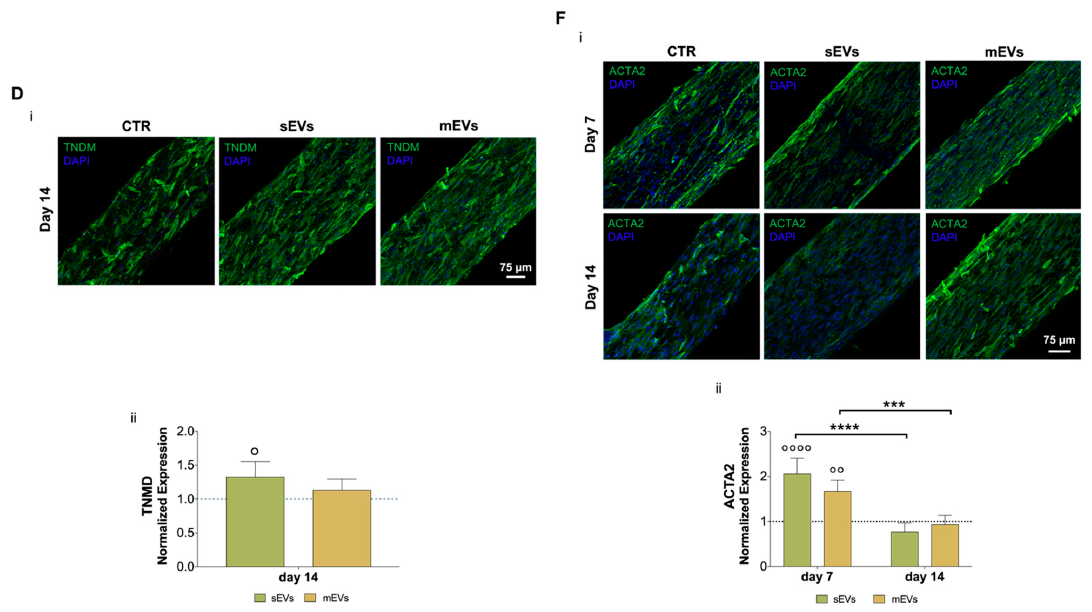
Figure 2. ( A ) Schematic representation of human tendon-derived stem cells (hTDCs) in culture over time. hTDCs were maintained in culture for 14 days to acquire a disease phenotype. Afterward, small extracellular vesicles (sEVs) and medium extracellular vesicles (mEVs) were added to the culture media of hTDCs to recover their healthy phenotype, which was evaluated after 7 and 14 days of culture. ( B ) (i) Confocal microscopy images of F-actin filaments (DAPI, blue; Phalloidin, red) of hTDCs supplemented with sEVs and mEVs after 14 days of culture. Scale bar: 75 µ m. (ii) Representative directionality analysis of F-actin filaments in hTDCs after 14 days (n = 3). ( C ) Gene expression profile of tenogenic markers (mohawk ( MKX ), scleraxis ( SCX ), tenomodulin ( TNMD )), after 7 days of culture (n = 4). Gene expression results are presented as fold changes with respect to the control group at each time point (represented by a line at 1). Statistical differences: ◦ p < 0.05 (against to the control). ( D ) (i) Confocal images of TNMD (green) at day 14. Images were counterstained with cells nuclei (DAPI, blue). Scale bar: 75 µ m. (ii) TNMD fluorescence intensity quantitative analysis. Data were normalized to the control (1). Data are presented as mean ± standard deviation (SD) (n = 6). Statistical differences: ◦ p < 0.05 (against to the control). ( E ) Gene expression profile of phenotypic drift markers (runt-related transcription factor 2 ( RUNX2 ) and SRY-Box transcription factor ( SOX9 )), after 7 and 14 days of culture. Gene expression results are presented as fold changes with respect to the control group at each time point (represented by a line at 1) (n = 4). ( F ) (i) Confocal micrographs of alpha-smooth muscle actin (ACTA2; green) at 7 and 14 days of culture. Nuclei were counterstained with DAPI (blue). Scale bar: 75 µ m. (ii) Quantification of ACTA2 fluorescence intensity. Data were normalized to the control (1). Data are presented as mean ± SD (n = 6). Statistical differences: *** p < 0.001, **** p < 0.0001 (among days for the same group); ◦◦ p < 0.01, ◦◦◦◦ p < 0.0001 (against to the